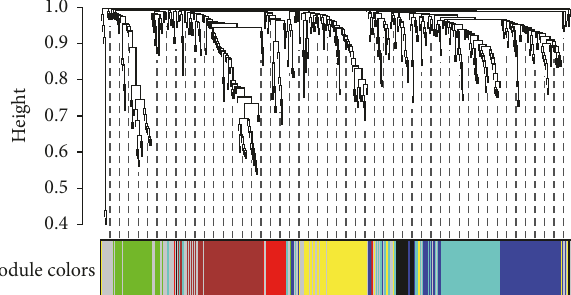
Figure 3: Metabolite dendrogram and module identification. Hier- archical cluster tree of the 449 metabolites, color-coded according to the modules identified using small dogs as the